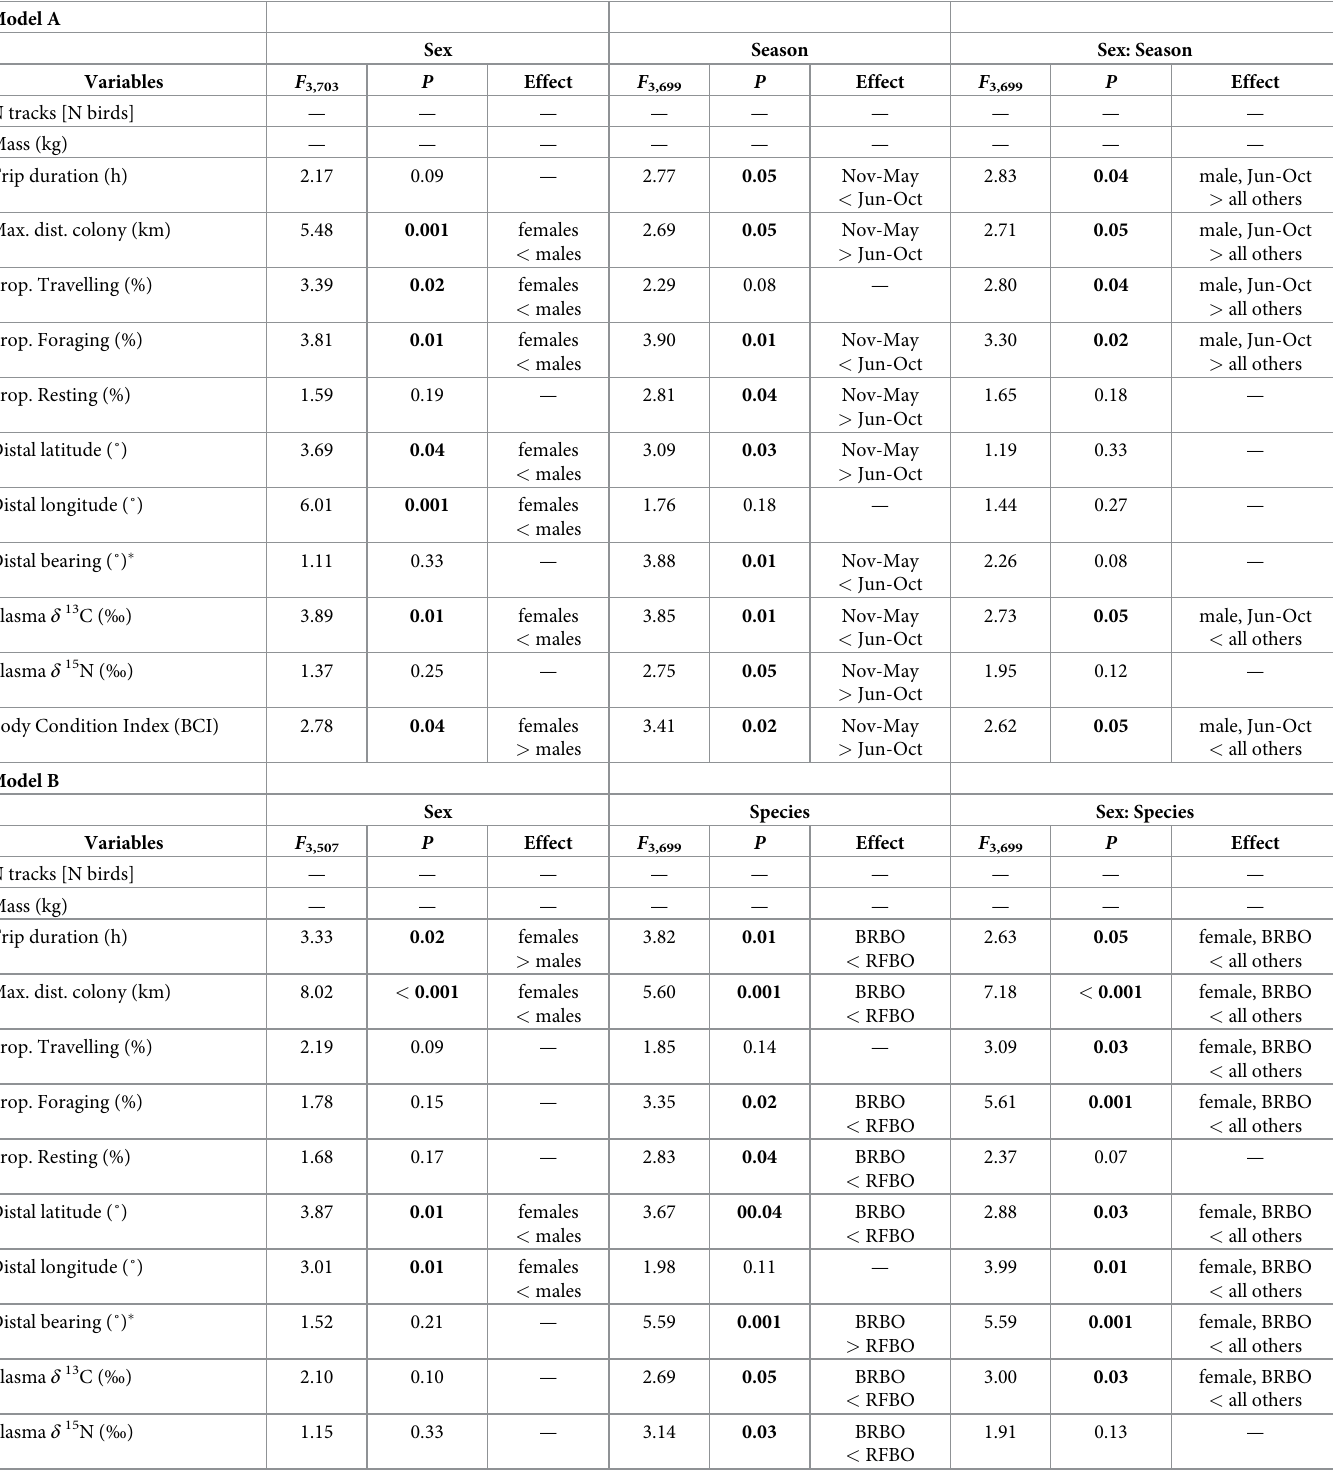
Table 3. A. Generalized Linear Mixed Models (GLMMs) testing the effect of (A) the interaction between sex and season (November-May vs . June-October) and (B) the interaction between sex and species (brown boobies-BRBO vs . red-footed boobies-RFBO) on trip characteristics, spatial distribution, trophic ecology and body condition shown in Table